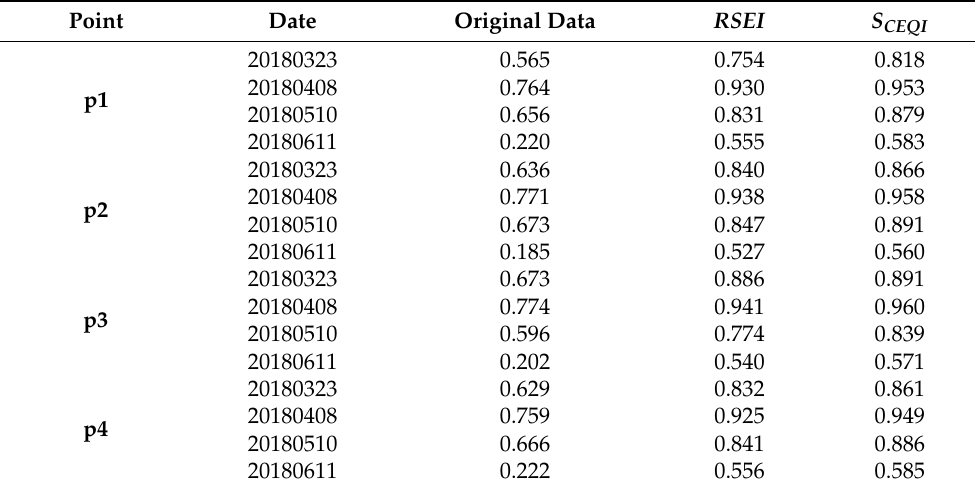
Figure 14. Comparison of different dimensionless results. Table 7. Results of different dimensionless methods .